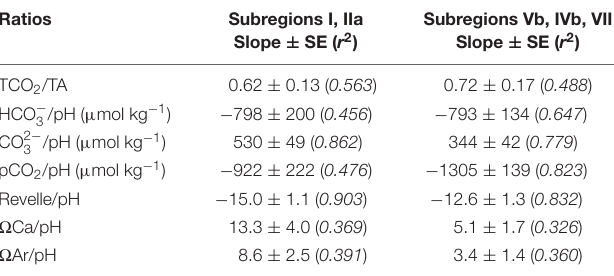
TABLE 3 | Slope, standard error and coefficient of correlation ( r 2 ) of the ratios between the in situ parameters of inorganic carbon system in IW in the first (I, IIa) and last (Vb, VIb, VII) subregions of OC2015